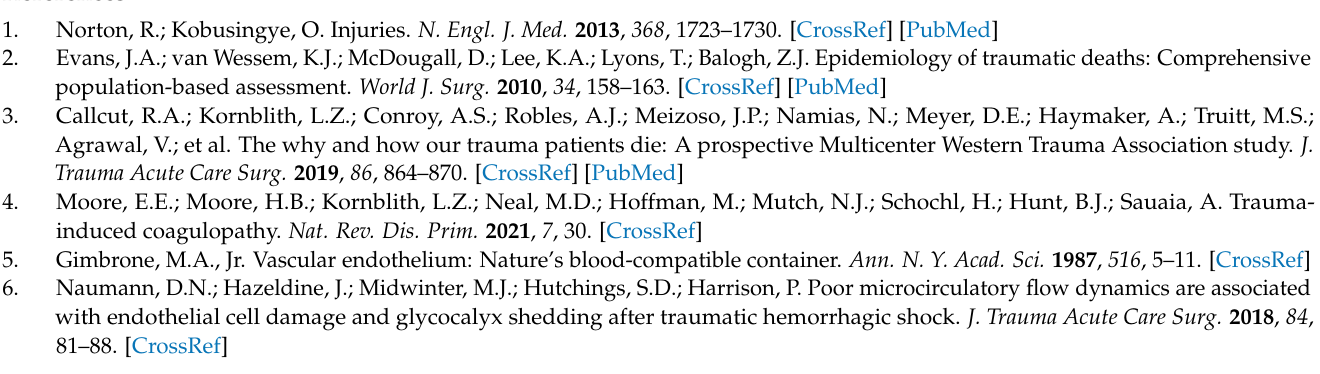
Table S4: MIFlowCyt-EV checklist, Figure S1: Calibration of the fluorescence detectors from arbitrary units to molecules of equivalent soluble fluorochrome and Figure S2: Forward scatter and side scatter calibration of the A60-micro by Rosetta